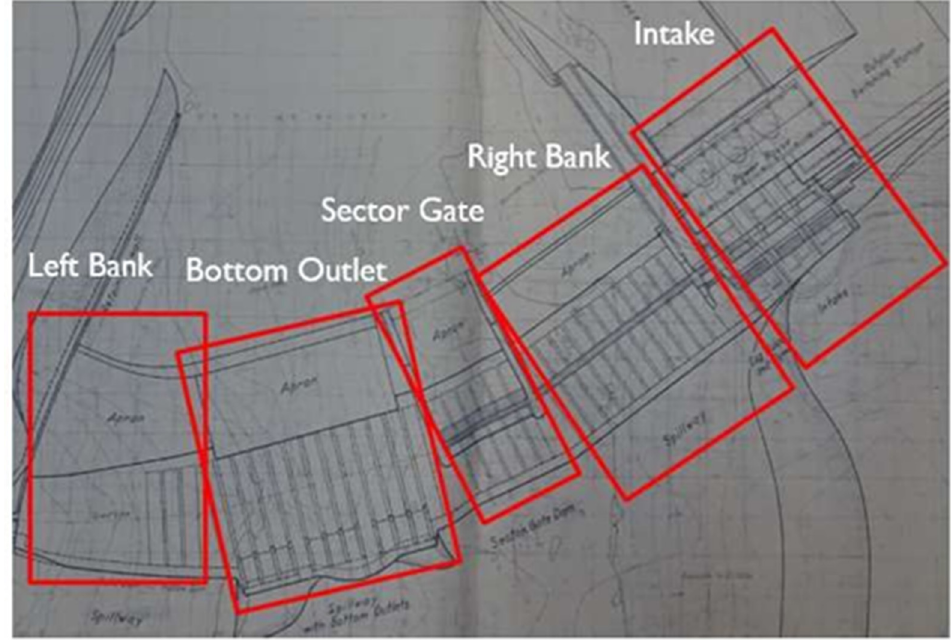
Figure 1. Top view of the overall Chenderoh Dam based on the provided drawing plans.